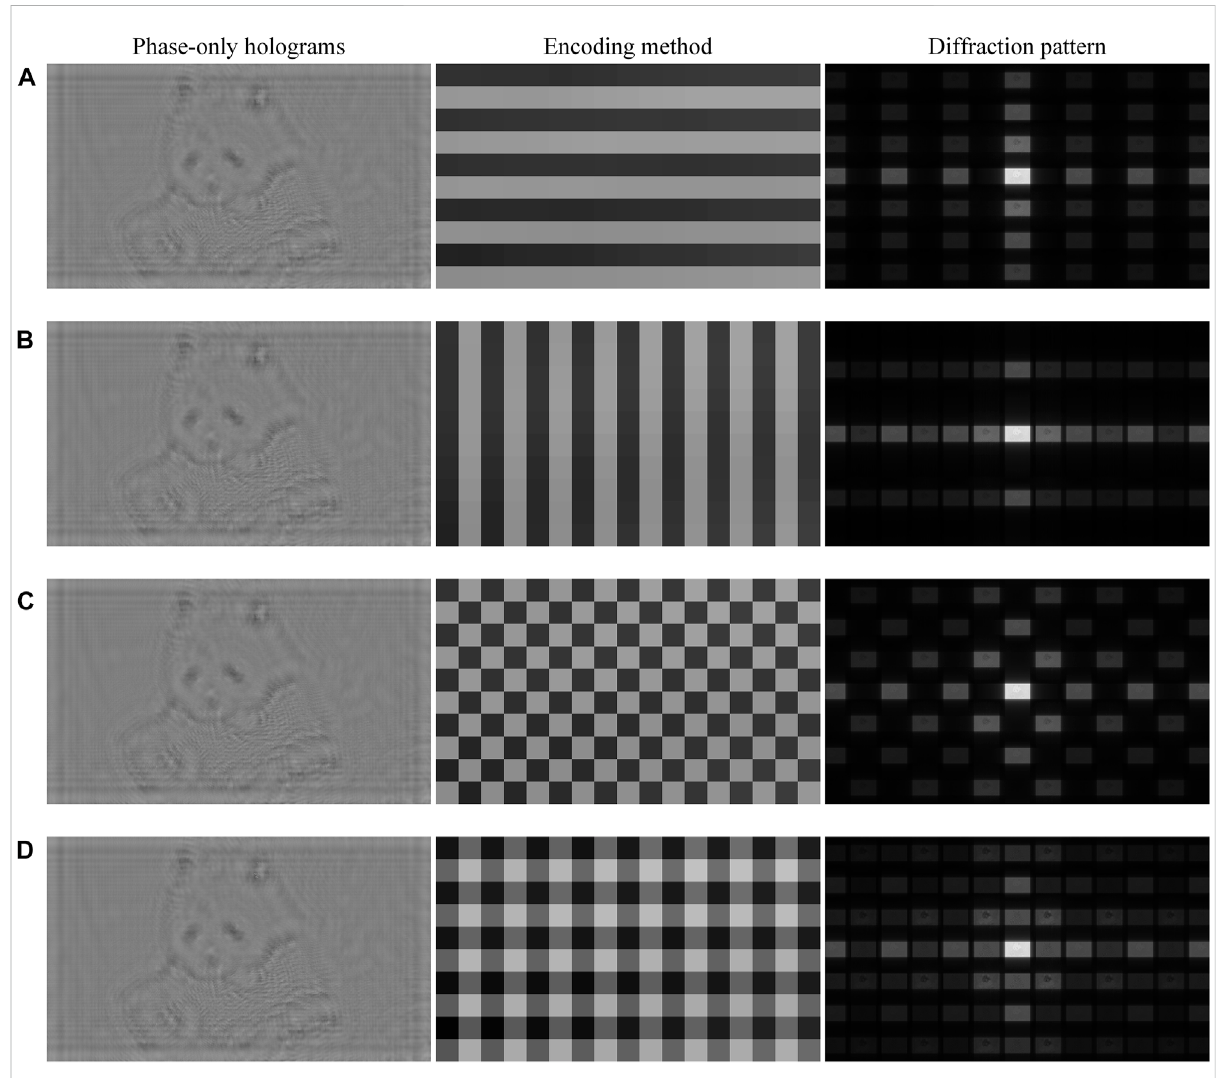
FIGURE 2 Phase-only holograms with different encoding methods and their diffraction patterns in numerical reproduction. (A) Strip-like encoding method in y -axis direction, (B) strip-like encoding method in x -axis direction, (C) checkerboard-like encoding method, and (D) grid-like encoding